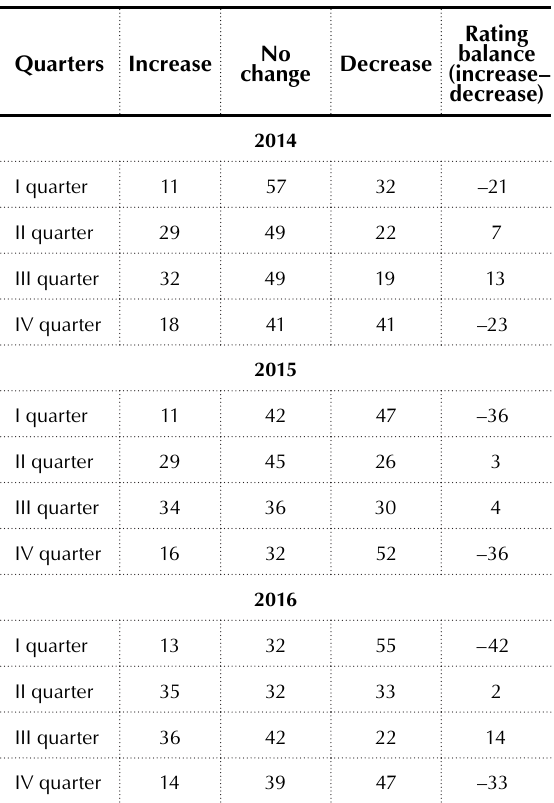
Table 2 (cont). Percentage of demand and its quarterly changes for the services of domestic tourism according to the survey of organizations engaged in tourism activities, according to the data (Ofitsialnaya statistika